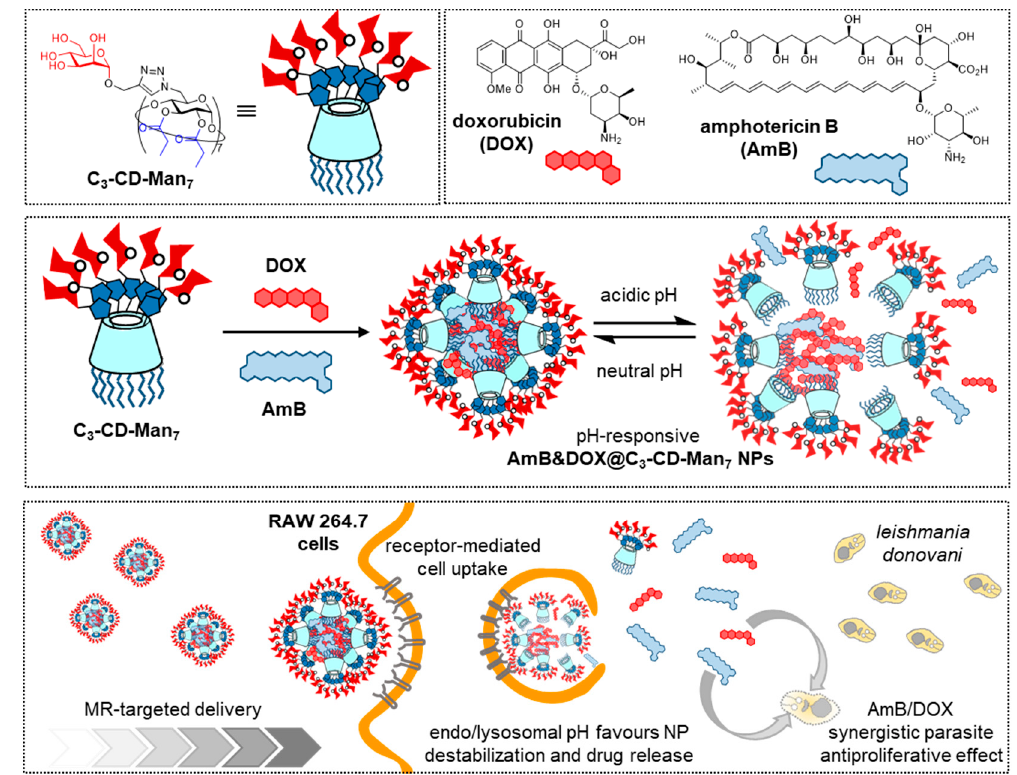
Figure 6. Structures of the GaCD derivative C 3 -CD-Man 7 , doxorubicin (DOX) and amphotericin B (AmB) (upper panel) and schematic representations of their co-assembly to afford pH-sensitive nanoparticles (Amb@DOX@C 3 -CD-Man 7 ) (middle panel) and internalization in macrophages to treat visceral leishmaniasis (lower panel), as reported by Seeberger, Yin and coworkers [55,57]. GaCD, glycoamphiphilic cyclodextrin; Man, mannose; NP, nanoparticle.